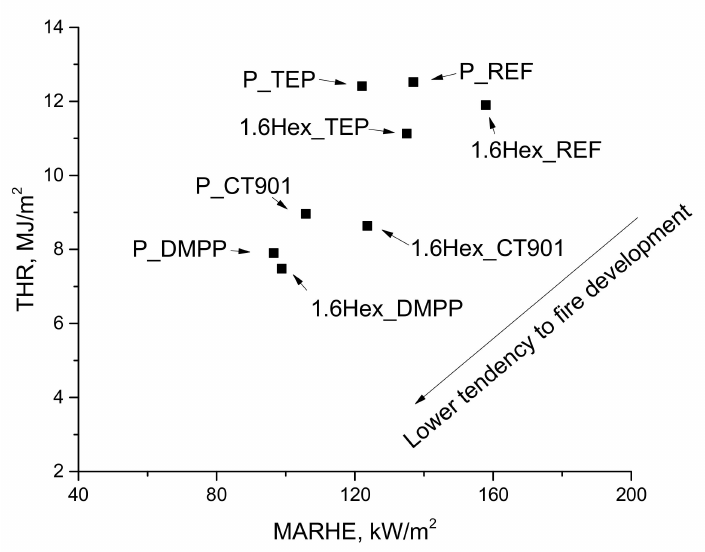
Figure 13. Dependence of the total heat release on MARHE.